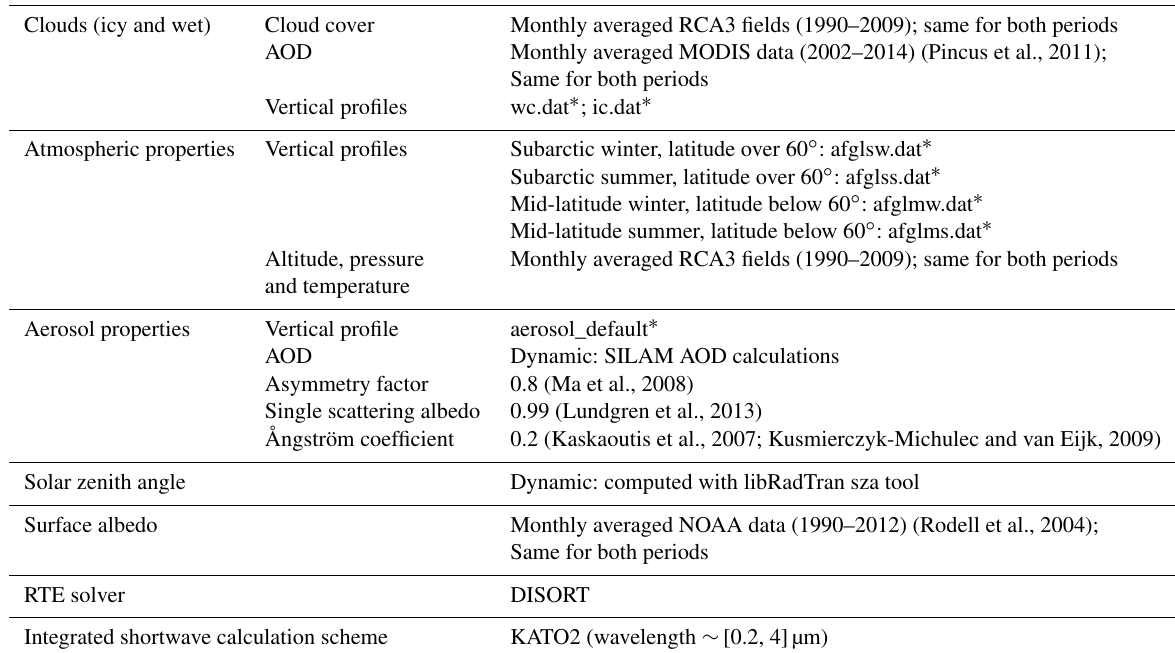
Table 2. Assumptions for the radiative transfer modelling libRadTran2.0 for present and future. Clouds (icy and